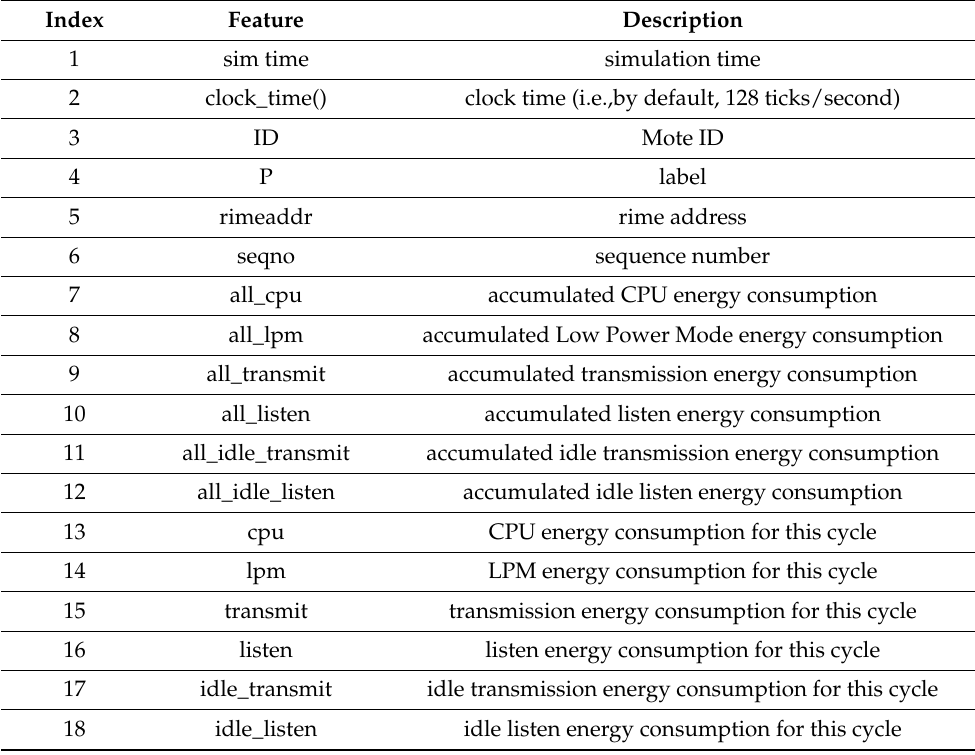
Table 1. “powertrace” plugin—Set of Captured Features.